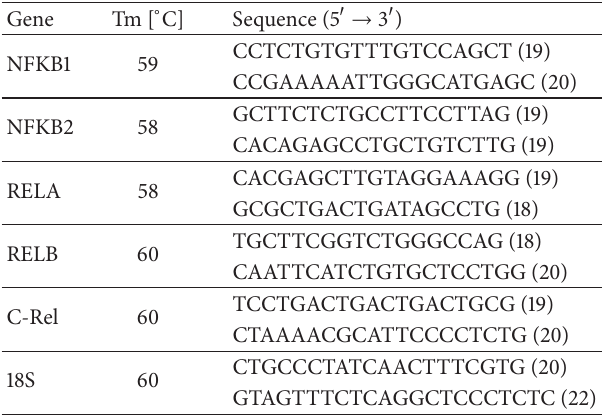
Table 1: Parameters for RT-qPCR